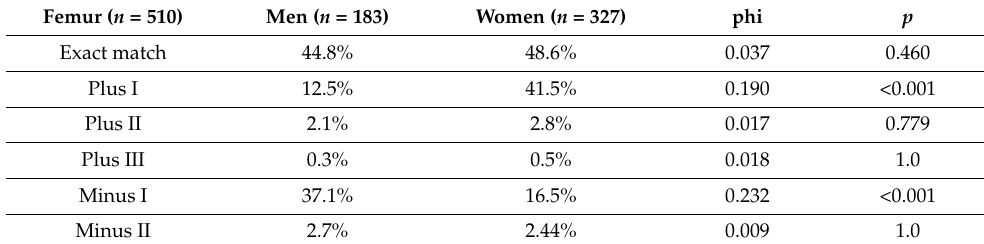
Table 2. Femoral planning adherence and sex; p (value of significance from Fischer’s exact test).